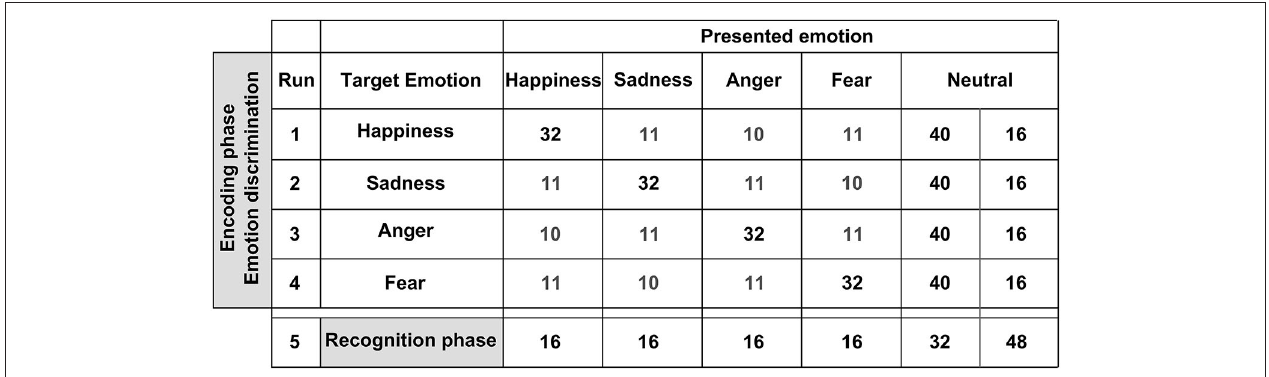
FIGURE 2 | Stimuli employed for the subsequent memory task. We used a modified version of the Facial Emotions for Brain Activation (FEBA) test. The upper panel depicts the encoding phase during which stimuli were presented in four runs. Within each run, one of the four emotions was the target emotion and 120 FEBA pictures were presented. The participants’ task during the incidental encoding phase was to indicate with their left index finger if the stimulus met the designated target emotion and to indicate with their right index finger if the stimulus displayed any other emotional expression or neutral. The lower panel depicts the recognition phase. Ninety six neutral pictures of the formerly emotionally presented target faces (4 × 16) and the formerly neutrally presented faces (32) were presented, as well as 48 pictures of new neutral faces. The participants’ task was to indicate with their left index finger if a facial stimulus had been presented before and with their right index finger if the facial stimulus showed a new